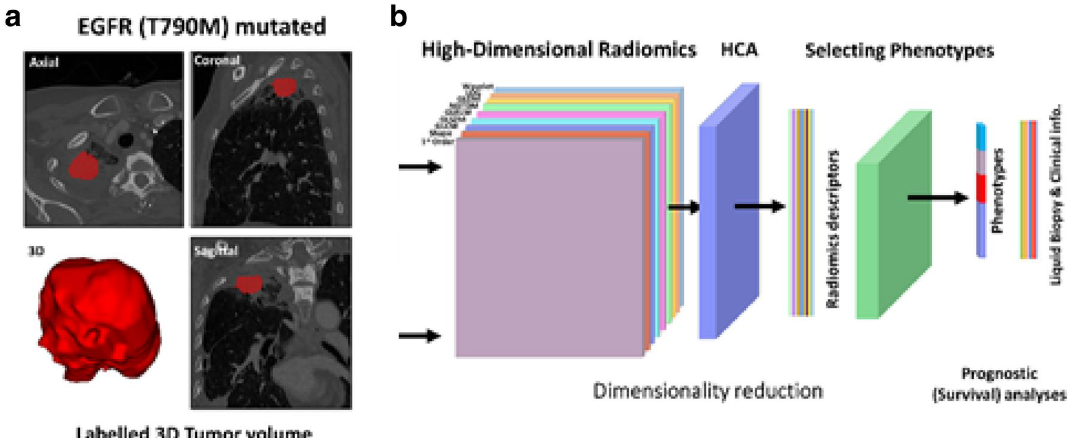
Figure 1. Tumor segmentation and radiomic analysis. ( a ) Example of segmentation of a tumor expressing the epidermal growth factor receptor (EGFR) T790M mutation. ( b ) Workflow of radiomics analysis where the tumor is segmented in 3D, followed by radiomic feature extraction, and two-level hierarchical clustering to first reduce feature dimensionality and then cluster the derived radiomic signatures into distinct tumor